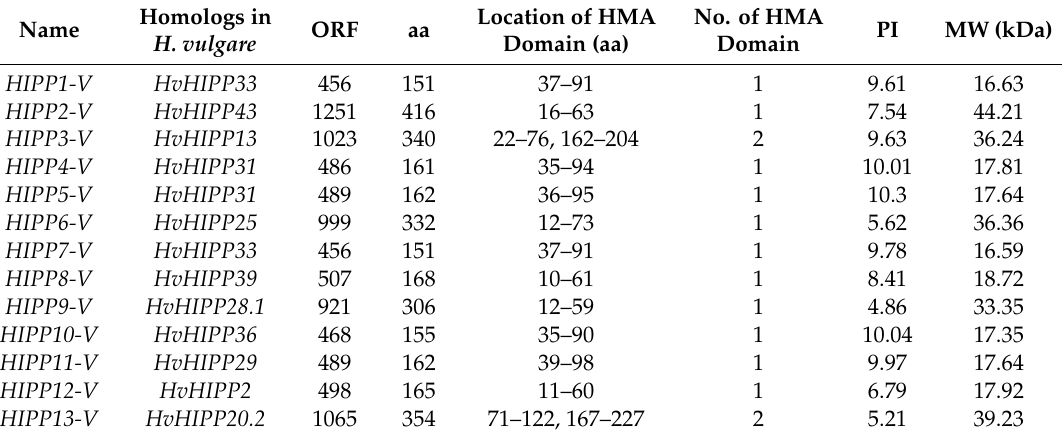
Table 2. Information of the HIPP gene family in H.